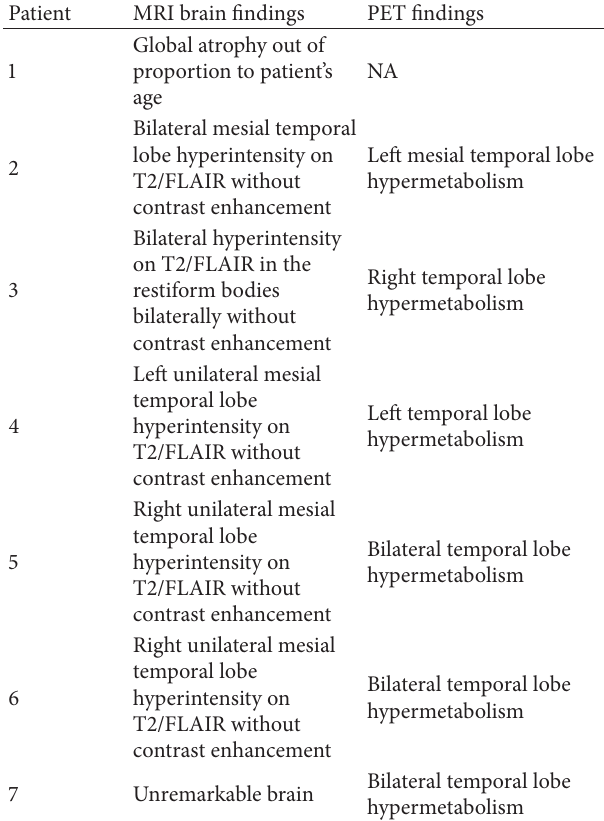
Table 3: MRI and PET